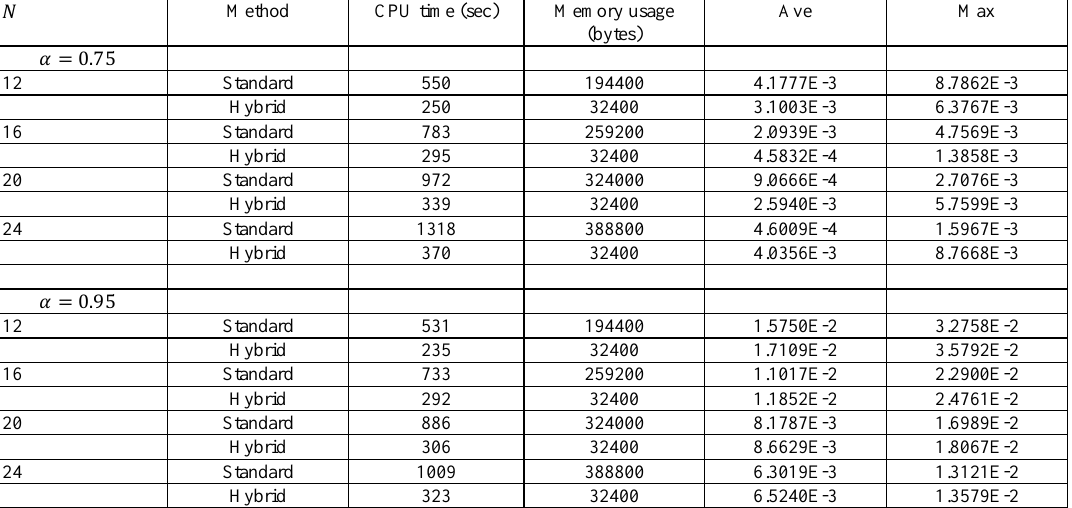
= ℎ = 1/45 for Example 2 𝑥 𝑦